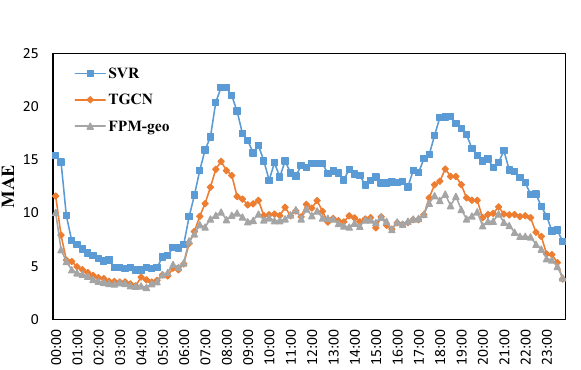
Figure 14. MAPE distributions based on the number of people in the grid.